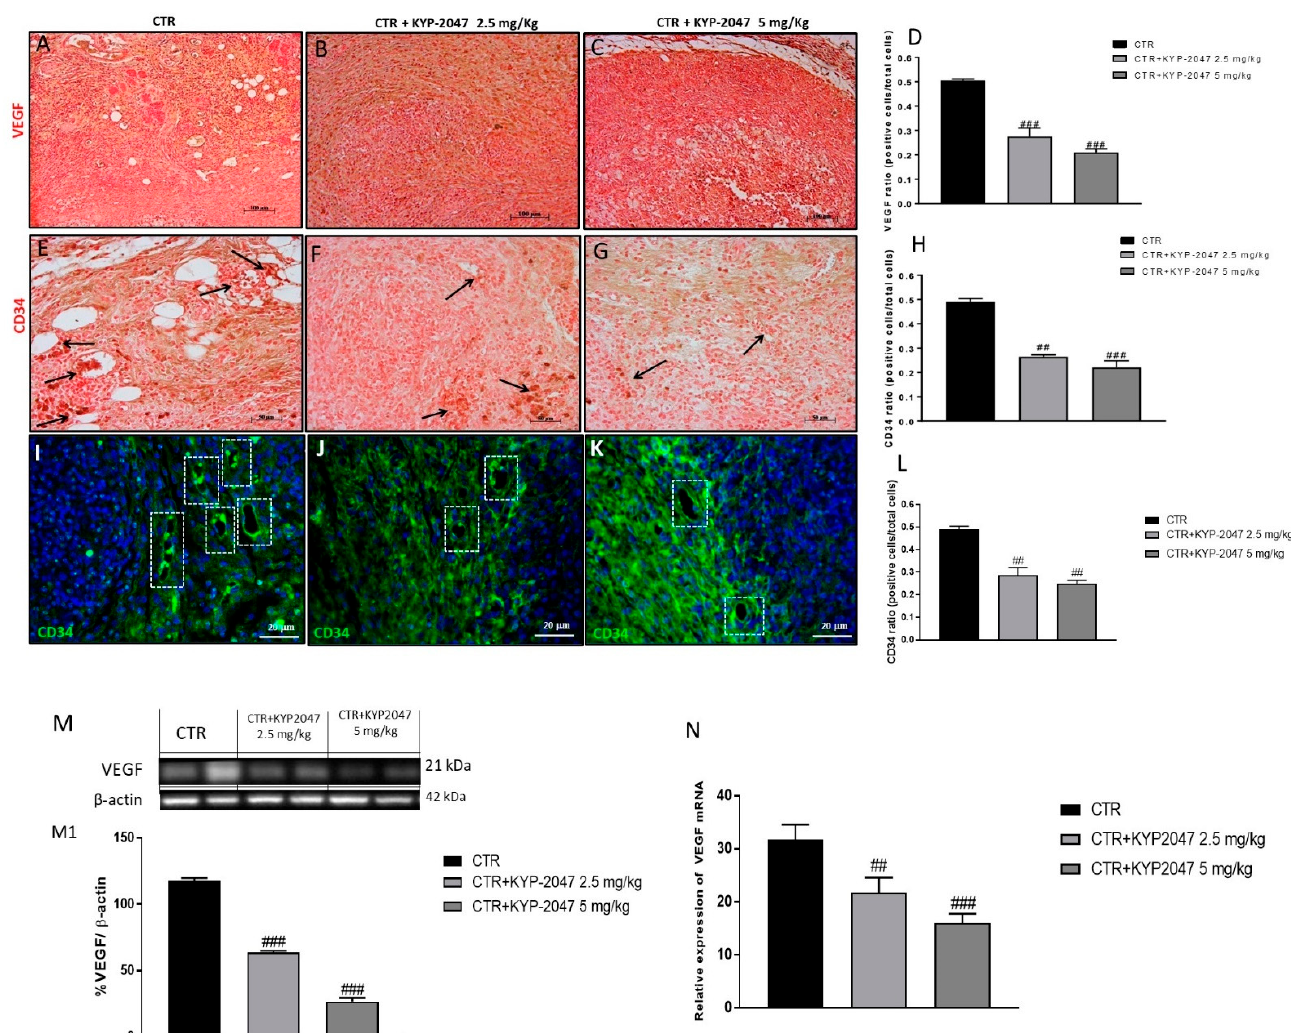
Figure 2. Effect of KYP-2047 on vascular endothelial-growth-factor (VEGF) and CD34 expression. Immunohistochemical staining showed a marked expression of VEGF and CD34 in the control group ( A , E ) whereas the treatment with KYP-2047 at doses of 2.5 mg/kg and 5 mg/kg significantly reduced their expression ( B , C , F , G ). Sections were observed and photographed at10 × , 20 × and 40 × magnification The data for VEGF were confirmed also by western blot analysis and quantitative real-time polymerase chain reaction (RT-qPCR), showing a decrease of VEGF expression following KYP-2047 treatment ( M , N ). Moreover, the data for CD34 were confirmed also by immunofluorescence assay ( I , J , K ). Data are representative of at least three independent experiments. ( D ) ### p < 0.001 vs. CTR; ( H ) ## p < 0.01 vs. CTR; ### p < 0.001 vs. CTR. ( L ) ## p < 0.01 vs. CTR; ( M ) ### p < 0.001 vs. CTR. ( N ) ## p < 0.01 vs. CTR; ### p < 0.001 vs.